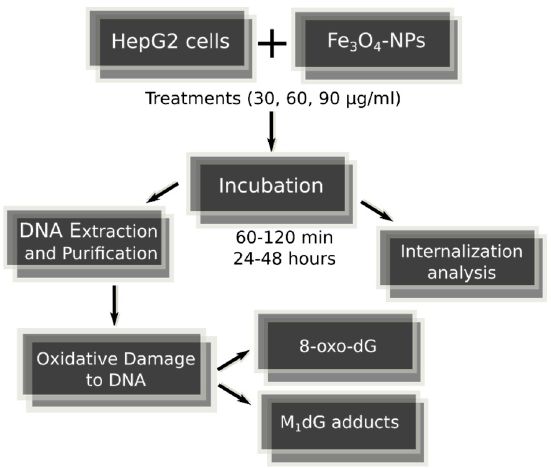
Figure 4. Strategy protocol of analytic research aimed to evaluate genotoxic activity of Fe 3 O 4 -nanoparticles with increasing dosages and incubation times in HepG2 cells.